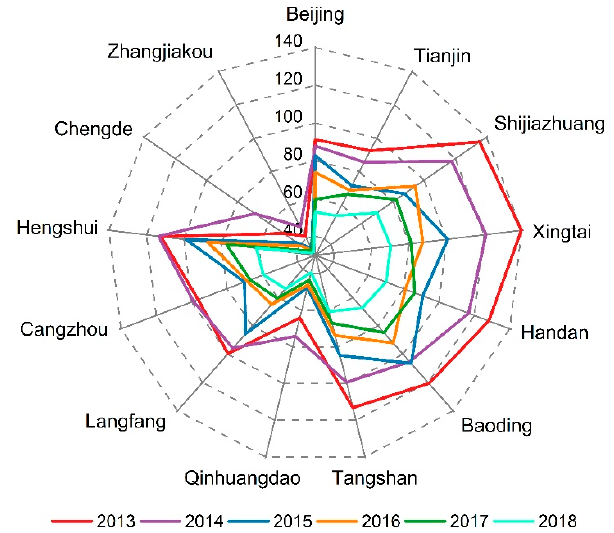
Figure 5. Annual variation of PM 2.5 mass concentration in different cities in BTH from 2013–2018. The numbers represent the PM 2.5 mass concentrations in μ g/m 3 .